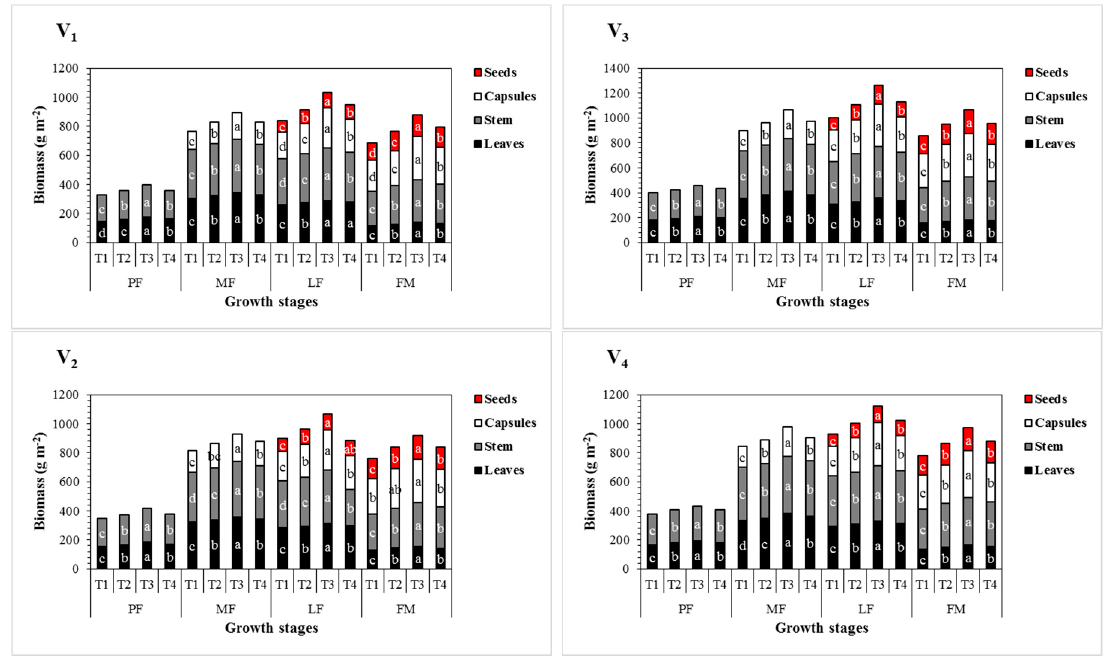
Figure 3. Biomass accumulation and partitioning in different plant parts of sesame varieties as affected by sulphur treatments averaged over 2012 and 2013 cropping seasons. PF, MF, LF and FM refer to four sesame growth stages pre-flowering, mid-flowering, late-flowering and full-maturity described by Langham (2007), V 1 , V 2 , V 3 and V 4 represent four sesame varieties SG-27, SG-30, SG-36 and SG-51 and T 1 , T 2 , T 3 and T 4 , represent four sulphur treatments 20, 30, 40 and 50 kg S ha − 1 respectively. Within a bar, different lowercase letters show a significant difference ( p < 0.05) between treatments. All the values are average of four replicates.